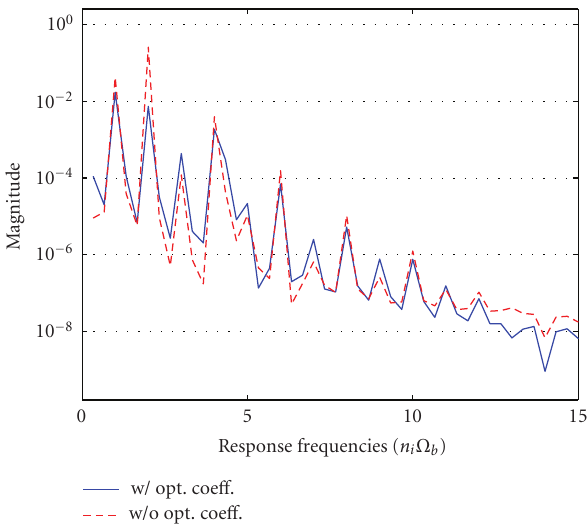
Figure 12: Vert. response mag. profiles at Ω b = 1 . 0, bearing 2.